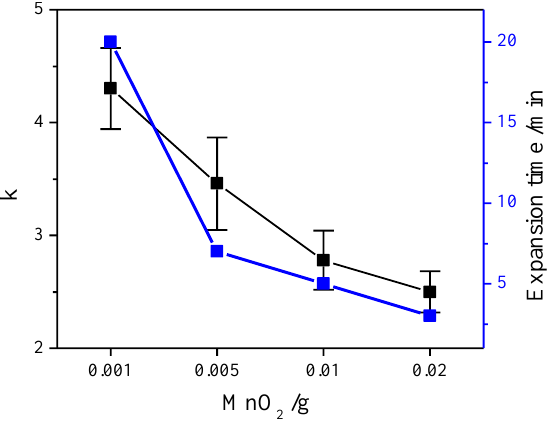
Figure 1. Effect of manganese dioxide on expansion rate and expansion time.